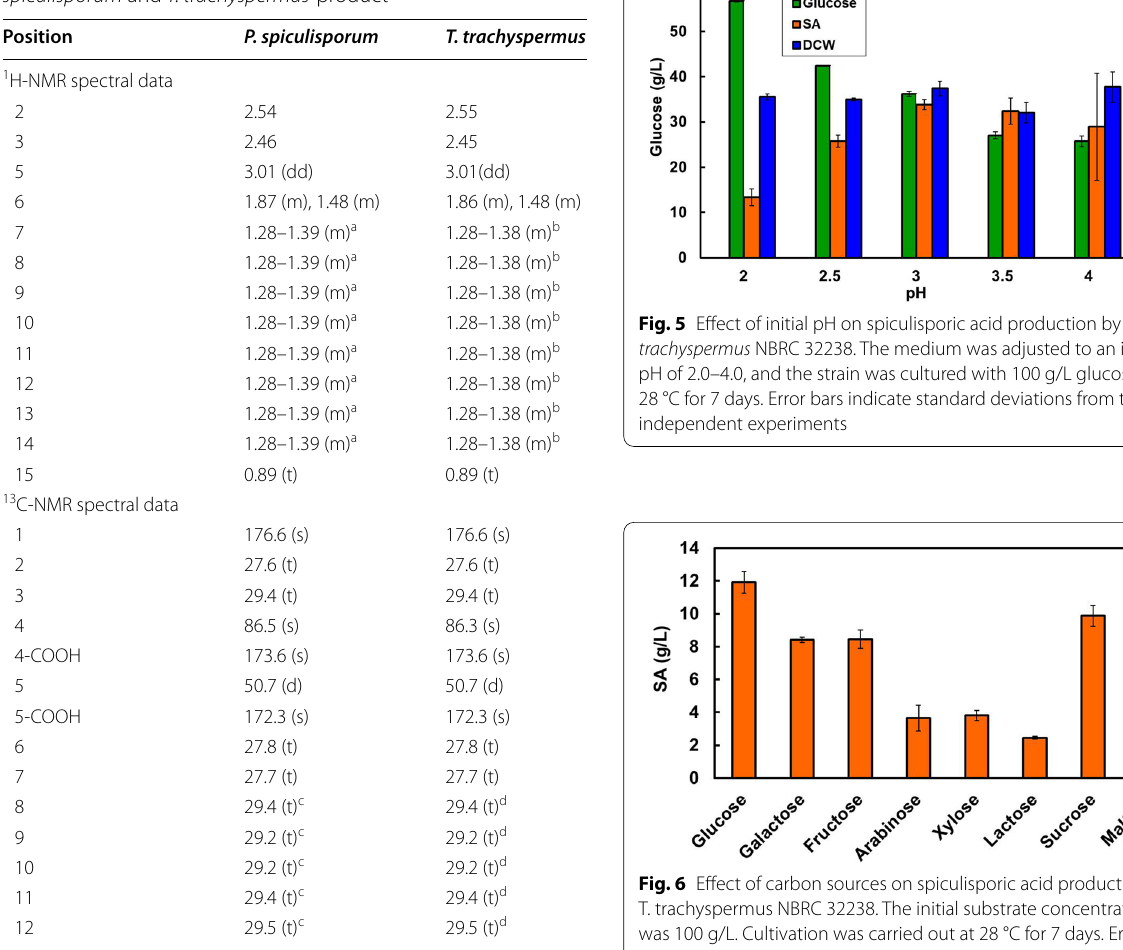
Table 1 NMR spectral data for commercial SA from P.